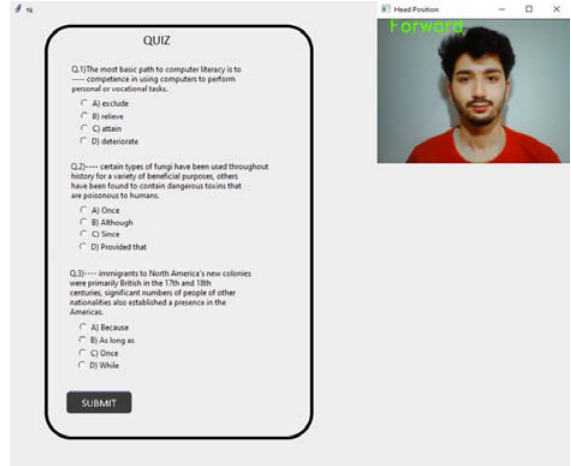
Figure 5 . The Exam System.